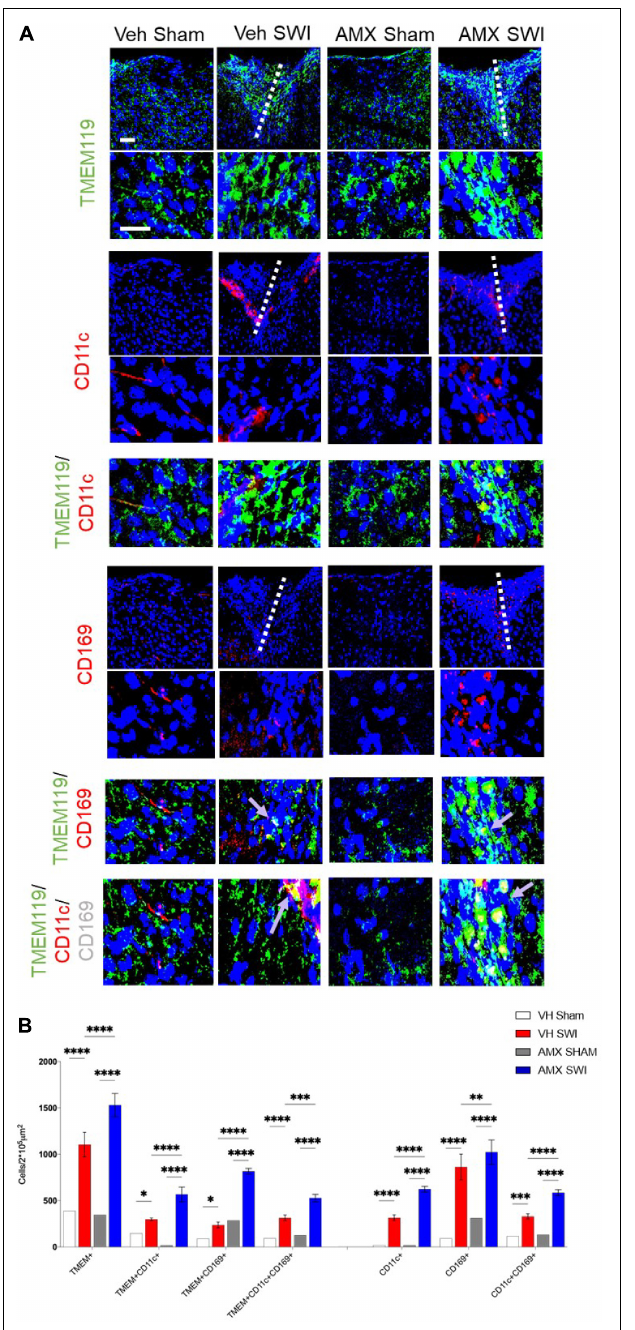
FIGURE 8 | Persistent effect of 7-days Tbk1 blockade on microglial DAM-like phenotype after 33 days of washout. (A,B) Mice were subject to cortical SWI injury and treated with AMX for 7 days; AMX was then withdrawn and mice were sacrificed 43 days later (40 days after injury). In AMX-treated mice, even after long wash-out, the density of CD11c + and CD169 + microglia (TMEM119 + ) remained significantly higher than in vehicle-treated animals. ( n = 3 animals/group with 4 sections/animal. Average ± SD, plus individual data points indicated; two-way ANOVA with Tukey post hoc ; ns: not significant, ∗ p < 0.05, ∗∗ p < 0.01, ∗∗∗ p < 0.001, ∗∗∗∗ P < 0.0001; full statistical report in Supplementary Table 10 ). Length of scale bars for both low-magnification and high-magnification insets is 200 µ m.